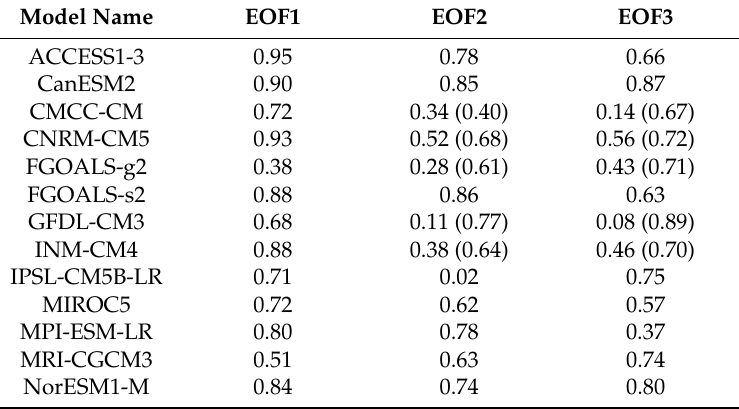
Table 2. Correlation coefficients of the spatial modes between CMIP5 models and NCEP reanalysis. (Correlation coefficients between the second (third) and third (second) modes are listed in parenthesis).